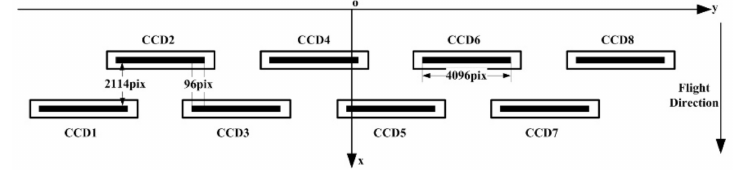
Figure 2. TH-1 HR camera focal plane assembly